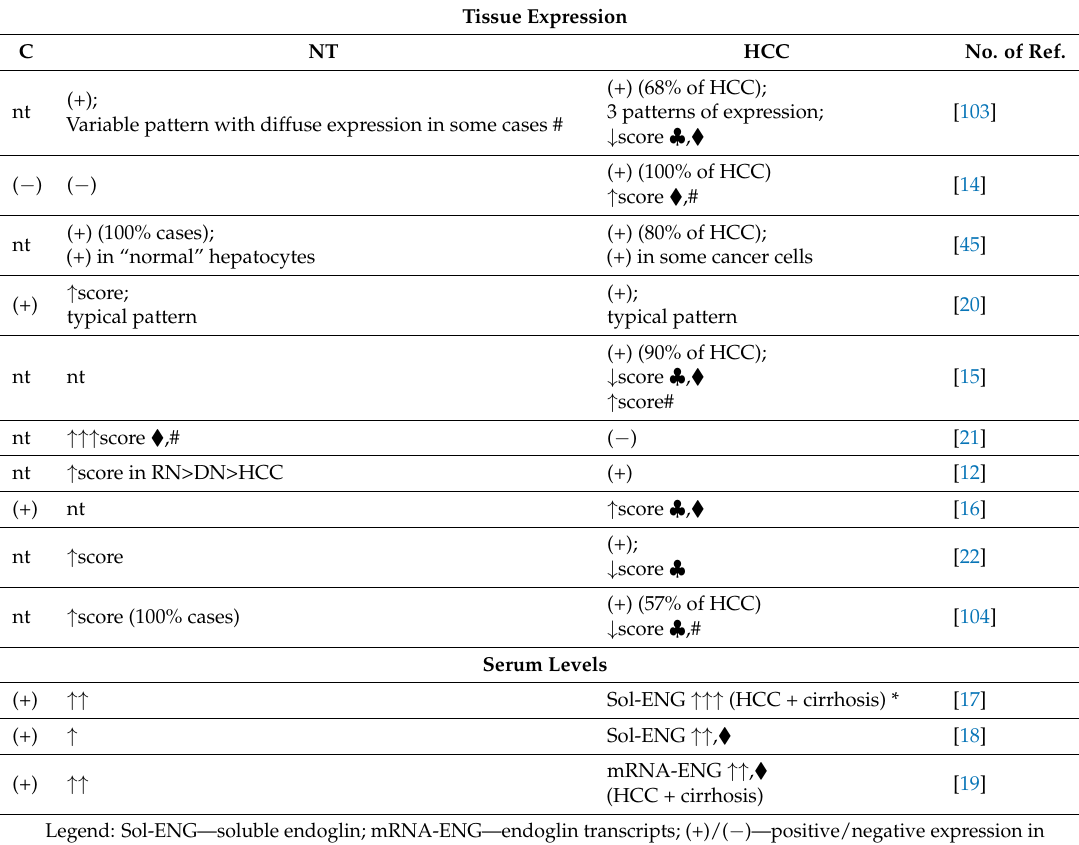
Table 2. Endoglin (CD105) tissue expression and serum levels in patients with HCC, non-tumour liver changes (including cirrhosis) (NT) and healthy liver